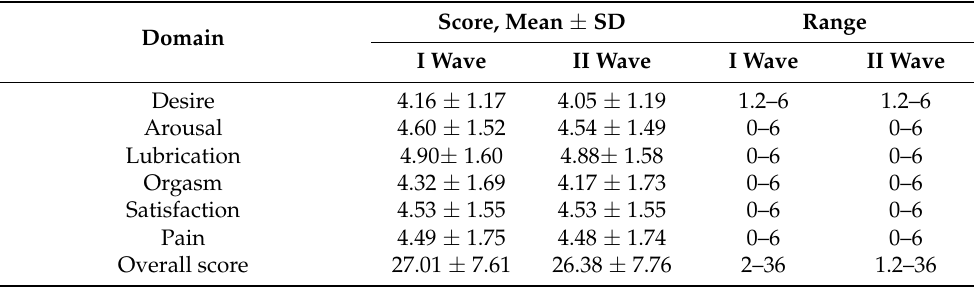
Female Sexual Function Index score during the first and second wave of the COVID-19